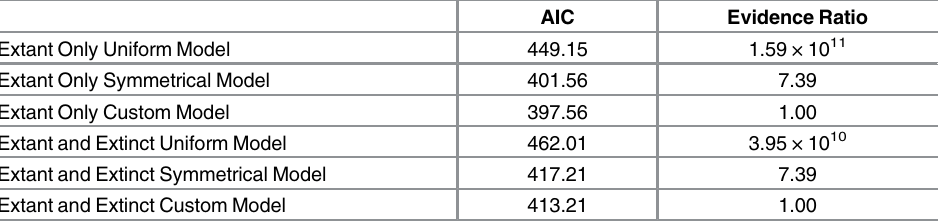
Table 10. AIC values and evidence ratios for tested parental care strategy character transition models in both extant only dataset and extinct and extant